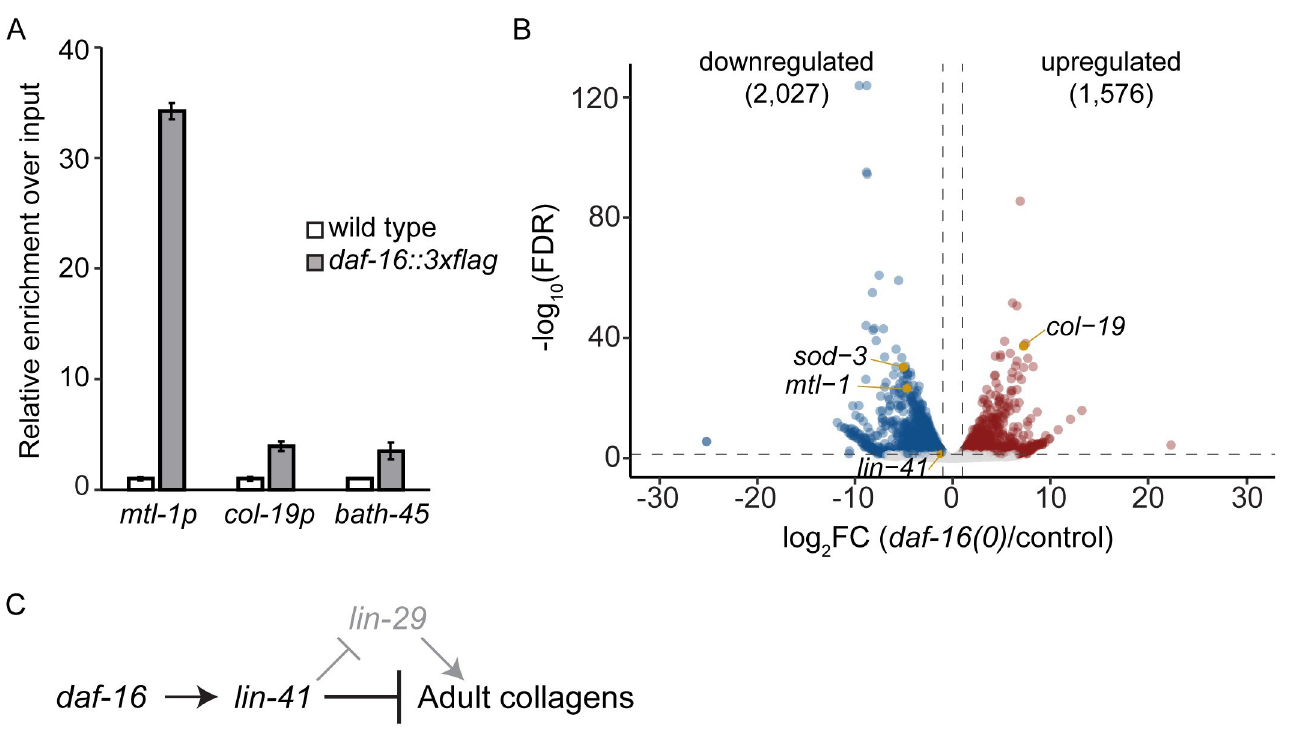
Fig 6. Gene expression changes in daf-16(0) dauer larvae. (A) DAF-16 is not enriched at the col-19 promoter. ChIP-qPCR experiments were performed on N2 or daf-16(ar620[daf-16 :: zf1-wrmScarlet-3xFLAG]) dauer larvae. Binding of DAF-16-3xFLAG was first normalized to input, and then to the average of the respective wild-type value (mean +/- SD for two technical replicates) is shown. Binding to the col-19 promoter was not observed, whereas there was substantial binding to the promoter of the known DAF-16 target mtl-1 [52,53].The coding region of the heterochromatinized gene bath-45 was used as negative control. A second biological replicate is shown in S11 Fig, and raw data are shown in S9 Table. (B) Volcano plot showing gene expression changes observed in daf-16(0) dauer larvae compared to control dauer larvae. Full mRNA-seq data can be found in NCBI under GEO accession number GSE179166. mtl-1 and sod-3 are known transcriptional targets of DAF-16 [52,53,74,75]. (C) Genetic model of the regulation of col-19p :: gfp and adult cell fate during dauer, based on data presented in the text.